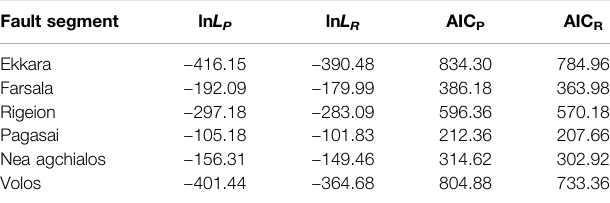
TABLE 7 | Log-likelihood and AIC calculated values of the Poisson and the Renewal models for the six segments of the Southern Thessaly Fault Zone for the M thr ≥ 6.0 adopted for the recurrence modeling. Subscripts P and R indicate the Poisson and the Renewal models, respectively. Fault segment ln L P ln L R AIC P AIC